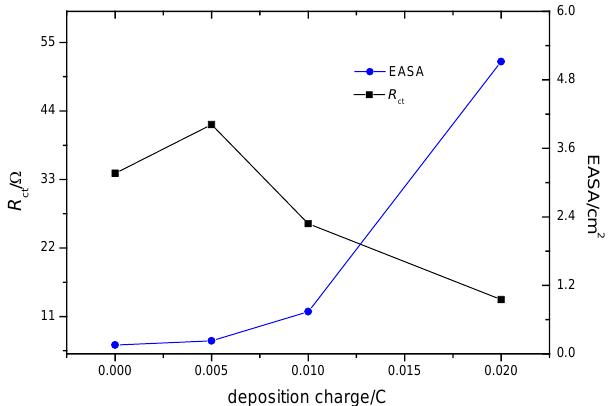
Figure 5. R ct and EASA of a platinum electrode in contact with an aqueous solution of 0.1 M (NH 4 ) 2 Fe(SO 4 ) 2 + 0.1 M (NH 4 )Fe(SO 4 ) 2 + 1 M HClO 4 after deposition of various amounts of platinum black as indicated in terms of deposition